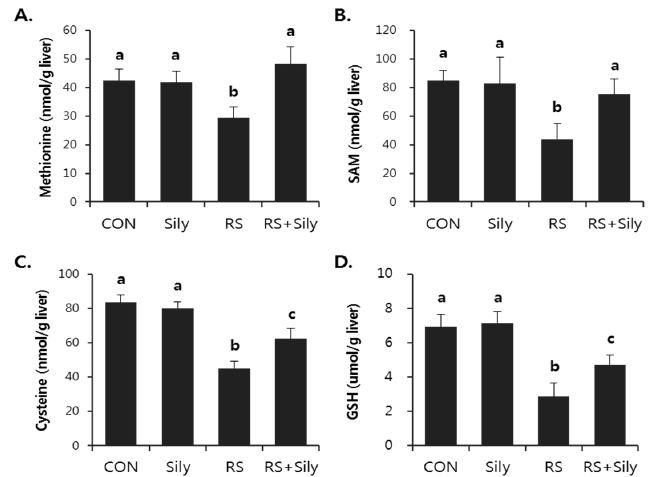
Figure 3. Silymarin ameliorated restraint-induced GSH depletion via down-regulation of sulfur-containing amino acid metabolism. Hepatic level of methionine ( A ); SAM ( B ); cysteine ( C ); and GSH ( D ) were determined. Each value is the mean ± SD for four mice. Values with different letters (a, b, c) are significantly different from one another (one-way ANOVA followed by Newman-Keuls multiple range test, p < 0.05). CON; control mice, Sily; only silymarin-treated mice, RS; restraint stressed mice, RS + Sily; restraint-stressed mice with silymarin treatment.